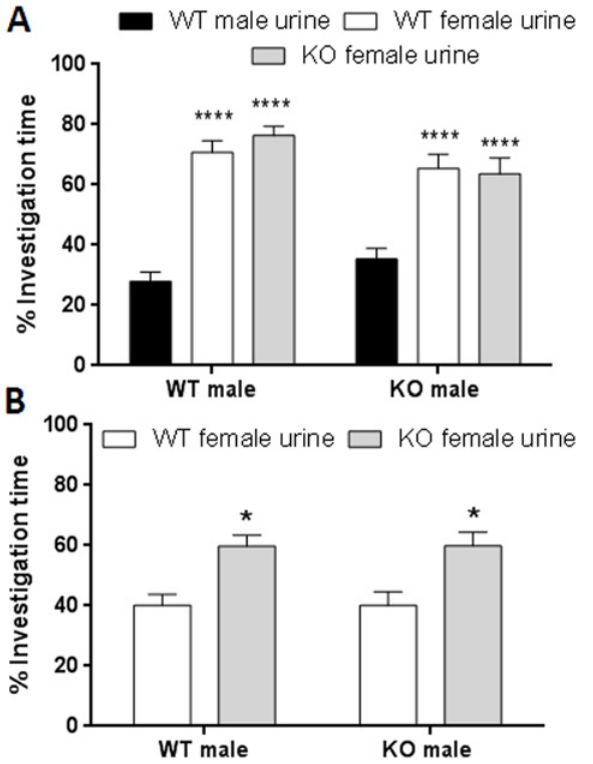
Fig 1. Male preference for urine scents from TPH2+/+ males versus TPH2+/+ females or TPH2-/- females. (A) % time spent investigating urine scents by TPH2+/+ (WT) or TPH2-/- (KO) males when given the choice between urine from a WT male versus urine from a receptive WT or KO female, (B) % time investigating urine scents by WT or KO males when given the choice between scents from a receptive WT female versus a receptive KO female. Data are expressed as the mean ± SEM for groups containing 9 WT and 10 KO males. Symbols indicate significant difference from the WT male. * p < 0.05; **** p < 0.0001.